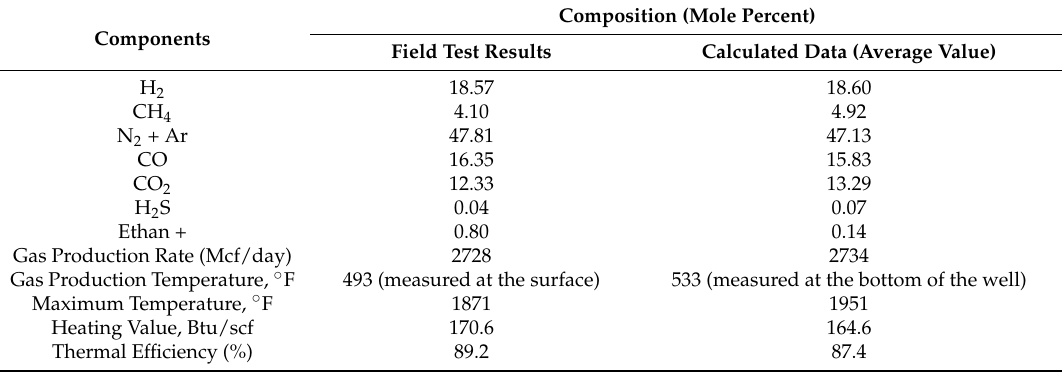
Table 11. Comparison of experimental and calculated data for an air injection rate = 1631 Mcf/day [45].